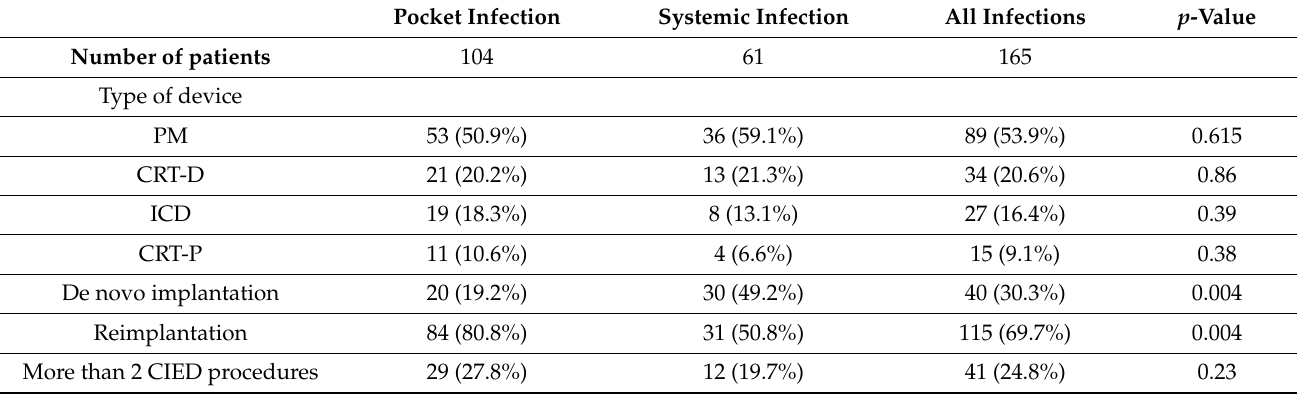
Table 2. Type of device and previous procedures in 165 patients who performed extraction due to CIED